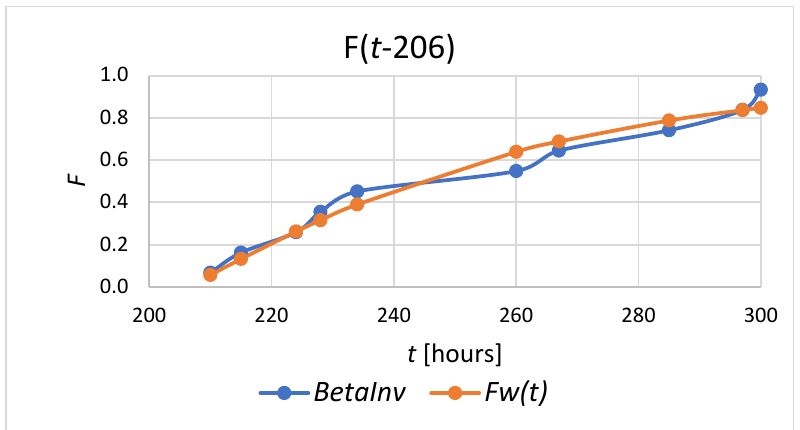
Figure 8. Distribution function graphs F ( t ‐ 206) that were obtained by the BETA.INV function and by the optimal three ‐ parametric Weibull model ( γ optimum = 206 h).